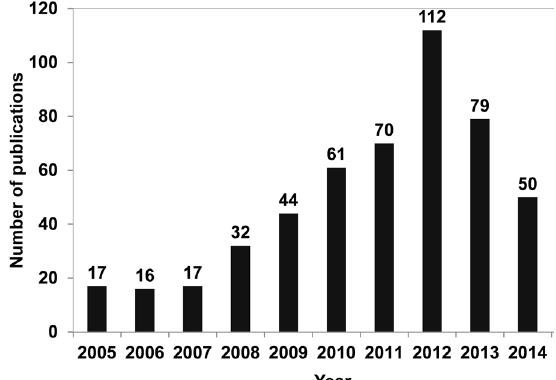
Figure 3 - Distribution of publications on citizen science (n=498) from 2005 to 2014 according to the type of publication. “Other types”: equal or less than 1% of the total.